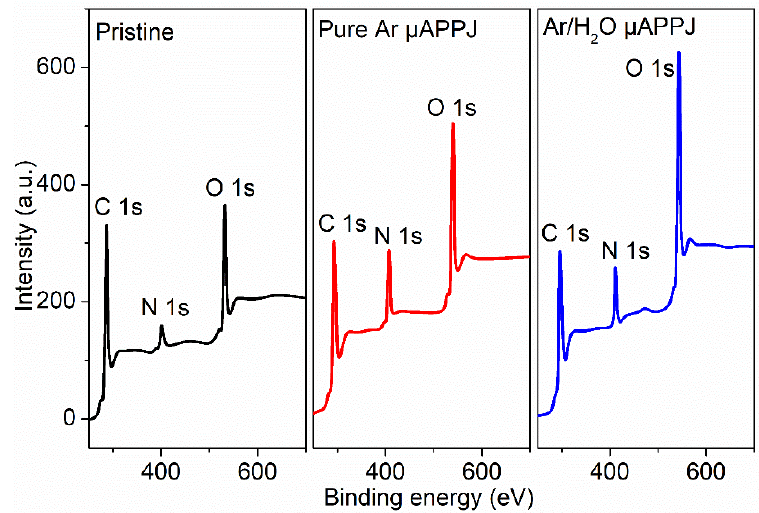
Figure 8. XPS spectra of pristine PI film and plasma-modified PI films by pure Ar and Ar/H 2 O microplasma jets.